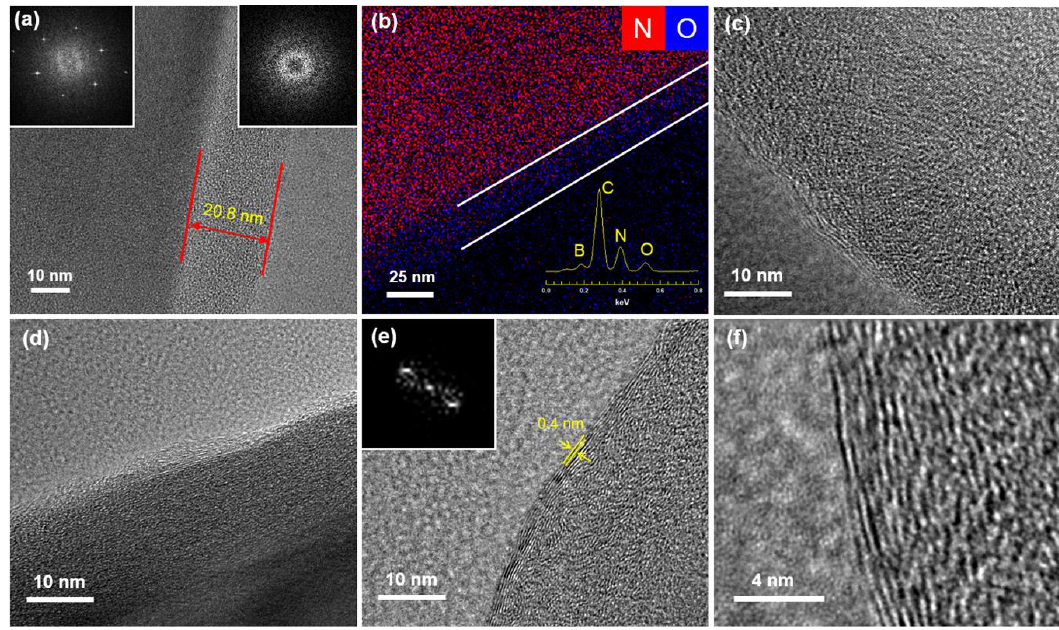
Figure 2. FE-TEM images of edge of ( a ) BNPDA, ( b ) EDS atomic analysis of BNPDA, FE-TEM images of edge of ( c ) BNPDA-400, ( d ) BNPDA-800, ( e , f ) BNPDA-1000.